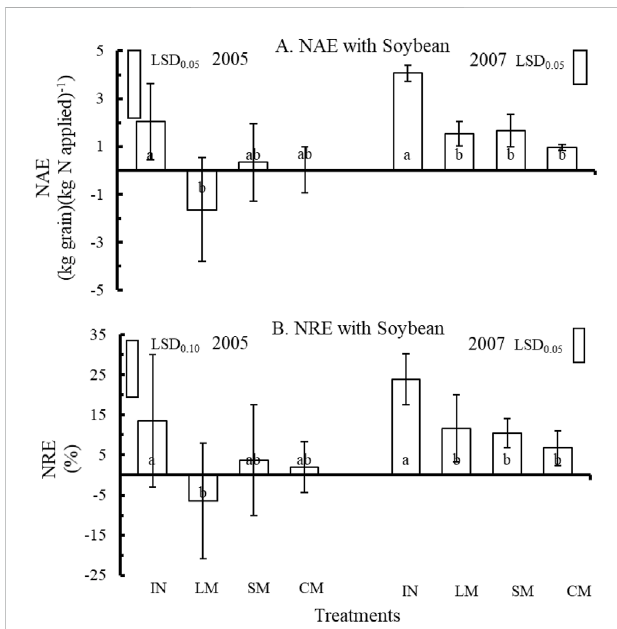
FIGURE 5 Changes in the selected N use ef fi ciency parameters for soybeans as affected by nutrient sources applied in preceding corn. NAE, N agronomicalef fi ciency,andNRE,Nrecoveryef fi ciency.Thebarsundera designated year and followed by different letters are signi fi cantly different as determined by the protected LSD. The abbreviations of IN, LM,SM,andCMreferredtothetreatmentswithinorganic fertilizer,liquid swine manure, solid swine manure, and composed swine manure,